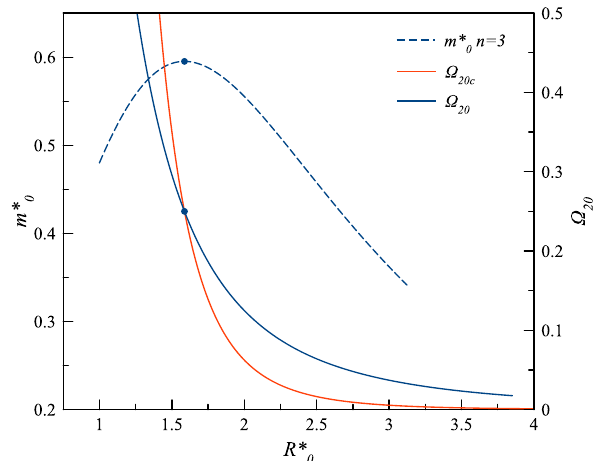
Ω 20 and 20 c curves for